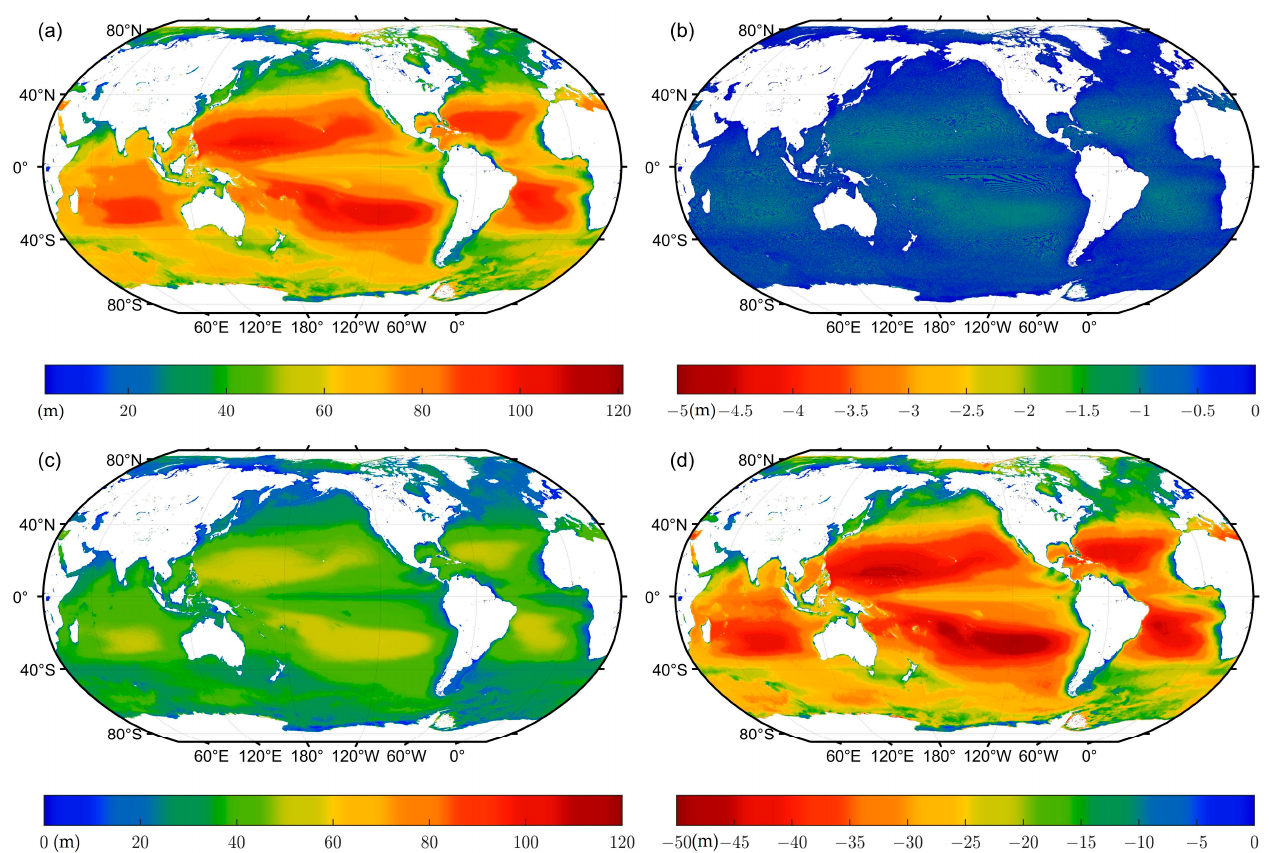
Figure 15. The maximum detectable depth during daytime with different receiver parameters and their differences with the results at night, ( a , b ) the FOV and ∆ λ is 0.15 mrad and 0.1 nm, respectively, and ( c , d ) the FOV and ∆ λ is 1.5 mrad and 1 nm, respectively.